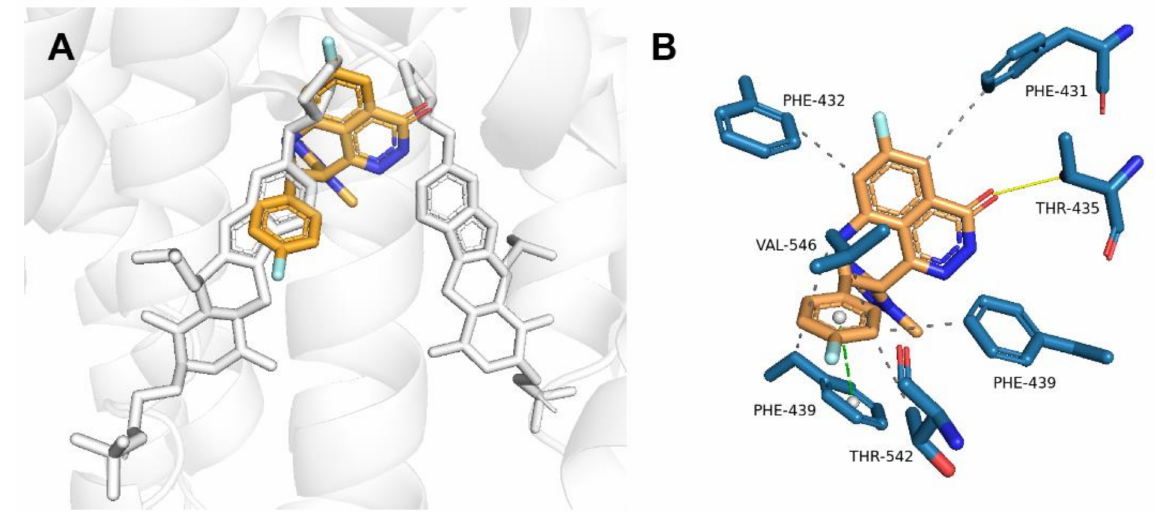
Figure 3. ( A ) ABCG2 with the predicted position of talazoparib (orange) relative to the ligand (gray sticks) that was originally cocrystalized with the transporter (PDB ID: 6HIJ). ( B ) ABCG2 residues (blue sticks) interacting with talazoparib. H-bonds are shown as yellow lines, π -stacking as green-dashed lines, and hydrophobic interactions as gray-dashed